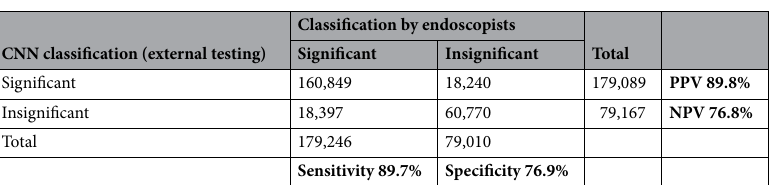
CNN classification (external testing)